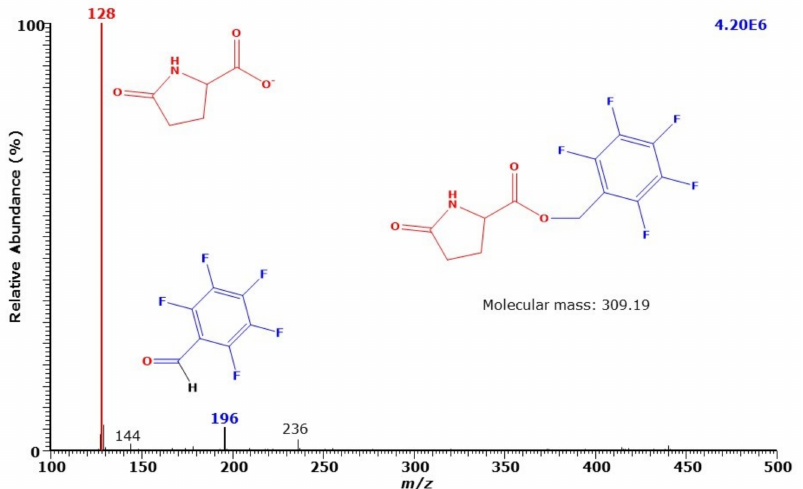
Figure 11. Mass spectrum in the ECNICI mode of the GC-MS peak with the retention time of 7.18 min (TP#1) obtained from the derivatization of synthetic pyroglutamate (5-oxo-proline, 10 nmol) with